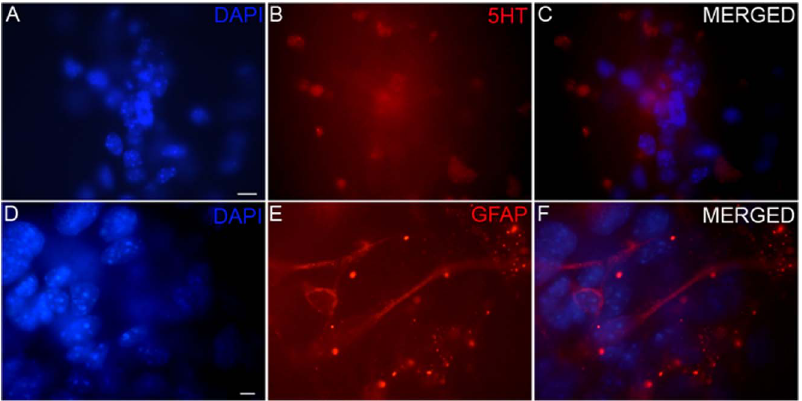
Figure 5. Presence of serotonin and GFAP positive cells in the differentiated cells. Immunocytochemical localization of serotonin (5-HT; B,C) and glial fibrillary acidic protein (GFAP; E,F) in 7 days differentiated cells showing glial (E) and few serotoninergic neurons (B) in the culture. Scale bar 10 m m.